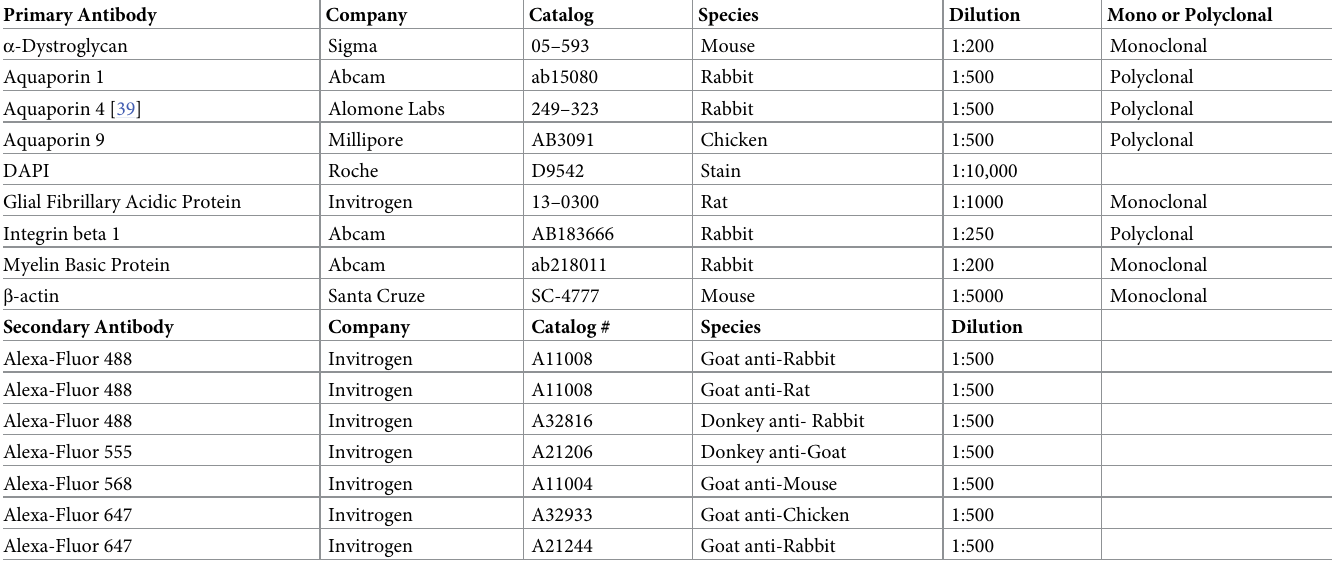
Table 1. Primary and secondary